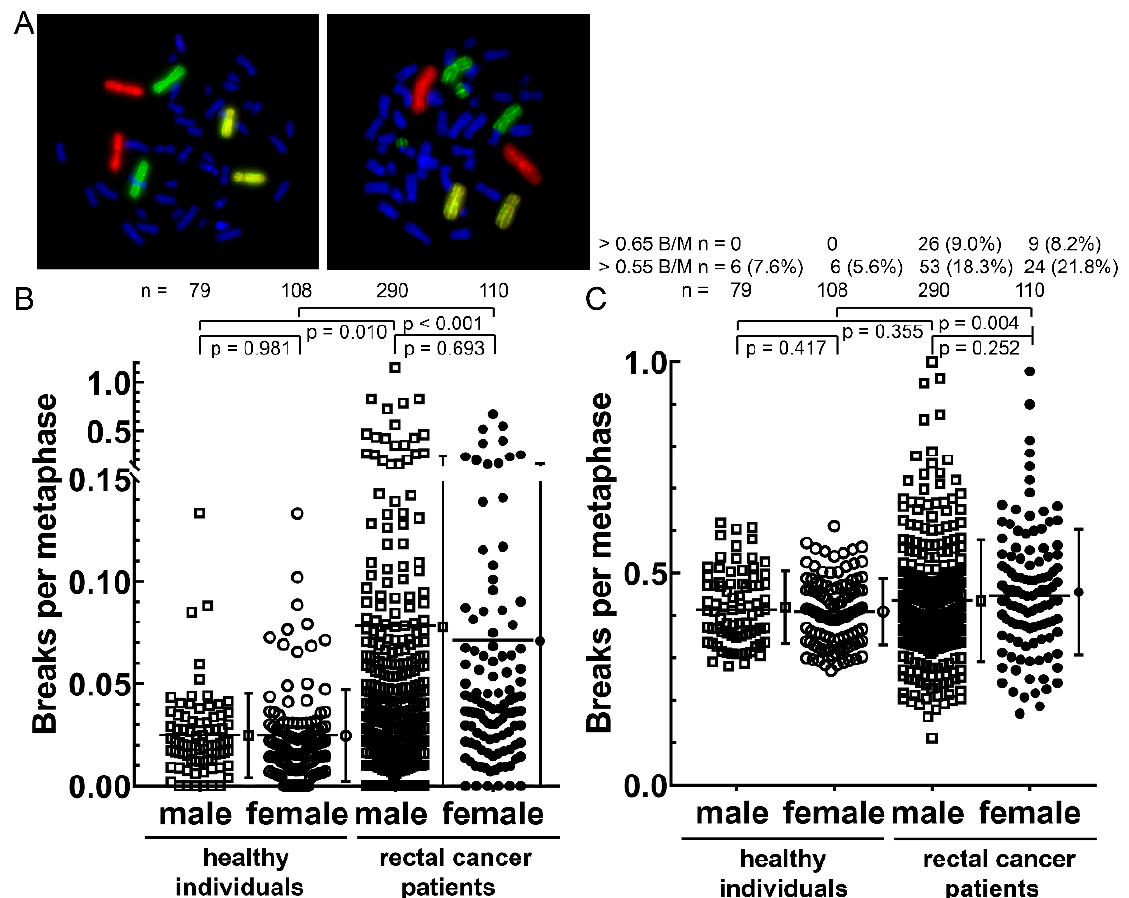
Figure 5. Radiosensitivity testing by three color fluorescence in situ hybridization of chromosomes #1, #2 and #4 (radiosensitivity cohort and healthy individuals). Metaphase spreads of human blood lymphocytes with chromosomes #1 (red), #2 (green) and #4 (yellow) stained. DNA was counterstained with DAPI (blue): ( A ) Normal metaphase spread in comparison to a metaphase spread with a translocation and a dicentric aberration each in chromosome #2, in sum scored with 4 breaks. Chromosomal aberrations in 179 healthy individuals and 400 patients suffering from rectal cancer; ( B ) Individual background B/M rates for both cohorts; ( C ) After ex vivo IR of 2 Gy. The mean and standard deviation are shown to the right of the dot plots; p -values were calculated by the Student’s t -test.